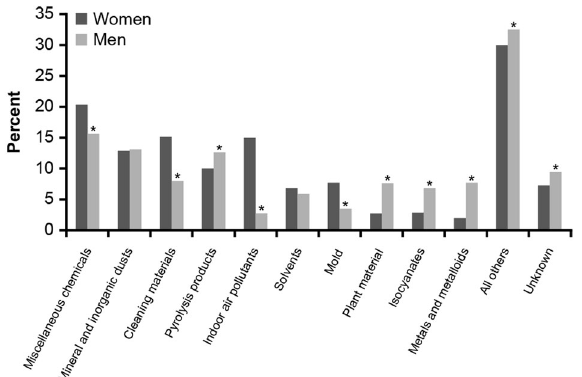
Fig. 1 Major categories for reported exposures associated with work-related asthma by gender. Categories de fi ned by the Association of Occupational and Environmental Clinics (AOEC), September 2012 5 ; * p -value for gender differences <0.05. Percen- tages are based on the number of females ( n = 4973) and males ( n = 3264). Adapted from White et al. 5 . Reproduced with permission from Taylor & Francis © 2014.